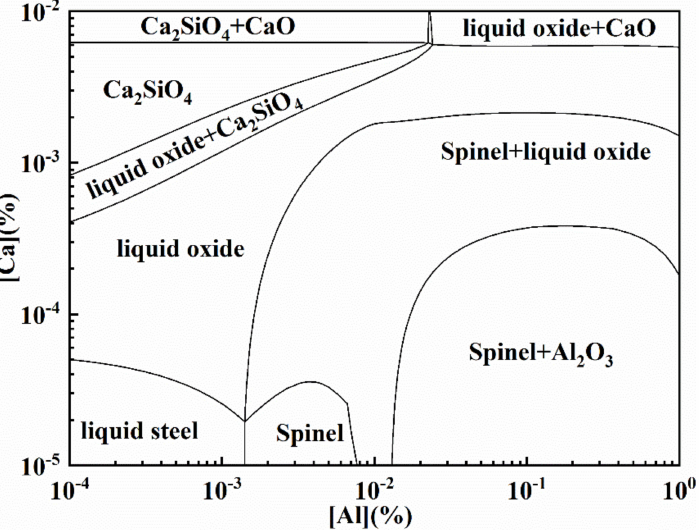
Figure 7. Stability phase diagram of Ca-Al-50 ppm O-5 ppm Mg in 15-5PH stainless (14.5%Cr-5.2%Ni- 3%Cu-0.7%Mn-0.4%Si-0.3%Mo-0.2%Nb-0.05%C-Fe) steel at 1873 K after Ca